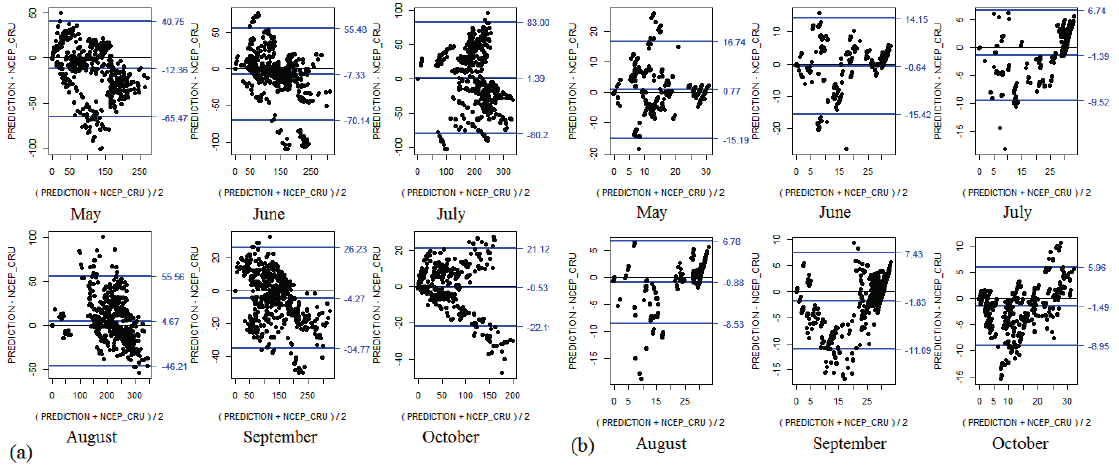
Figure 3. Bland-Altman scatter plot of spatially aggregated averages of prediction and NCEP-CRU data plotted against their differences for the months of